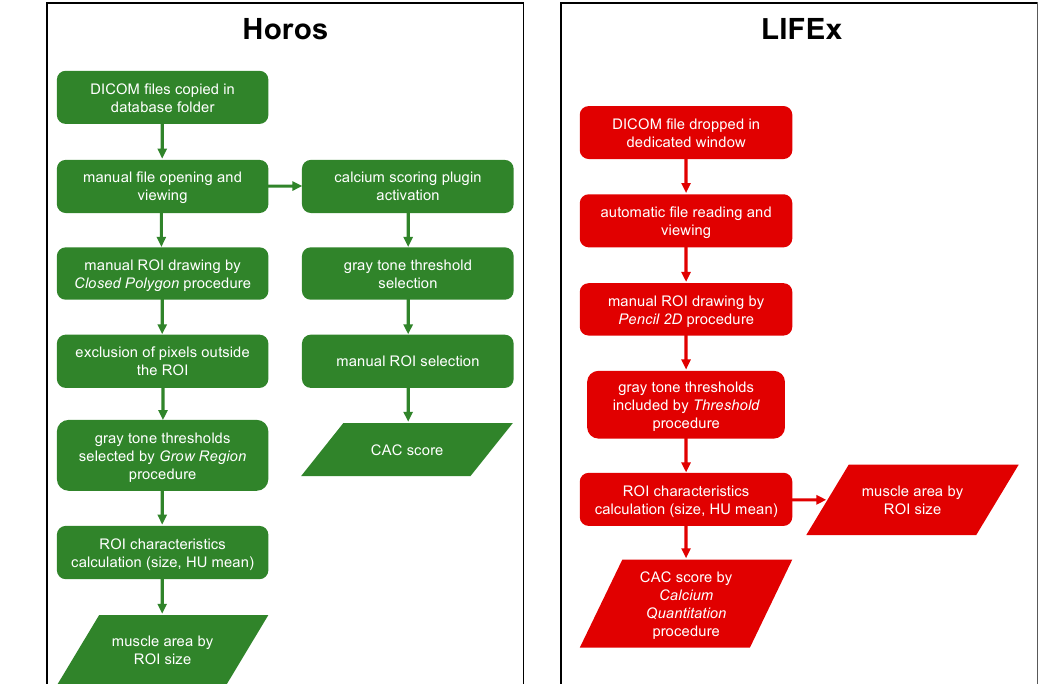
Figure 1. Horos and LIFEx pipelines.